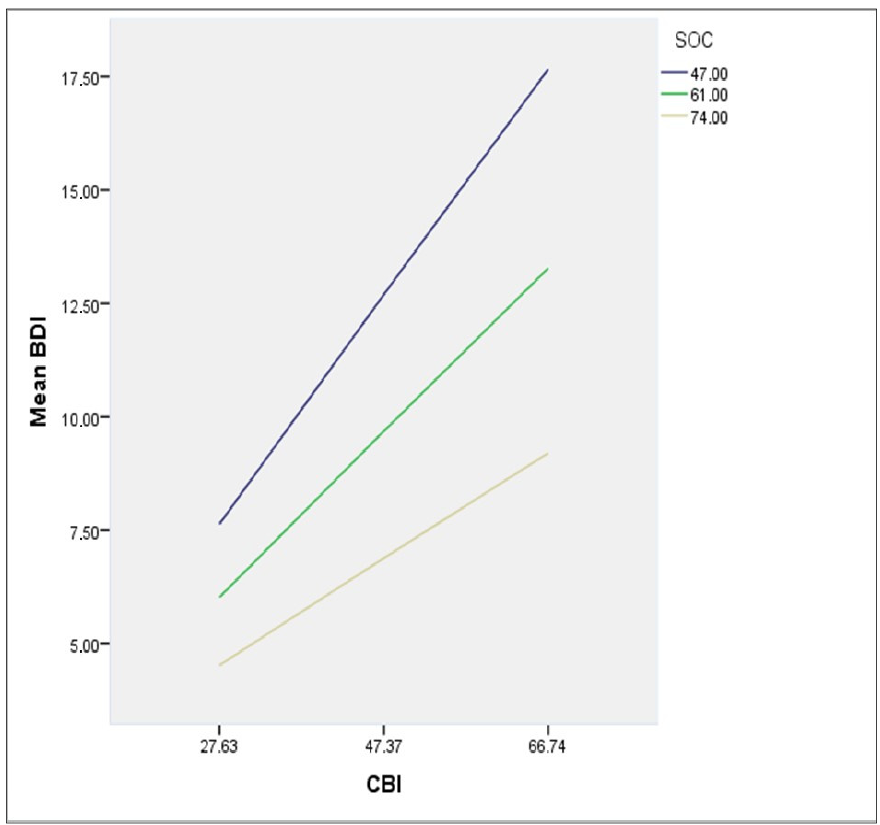
Figure 2. The moderation effect of SOC, between CBI and BDI relationship, at low (47) middle (61)